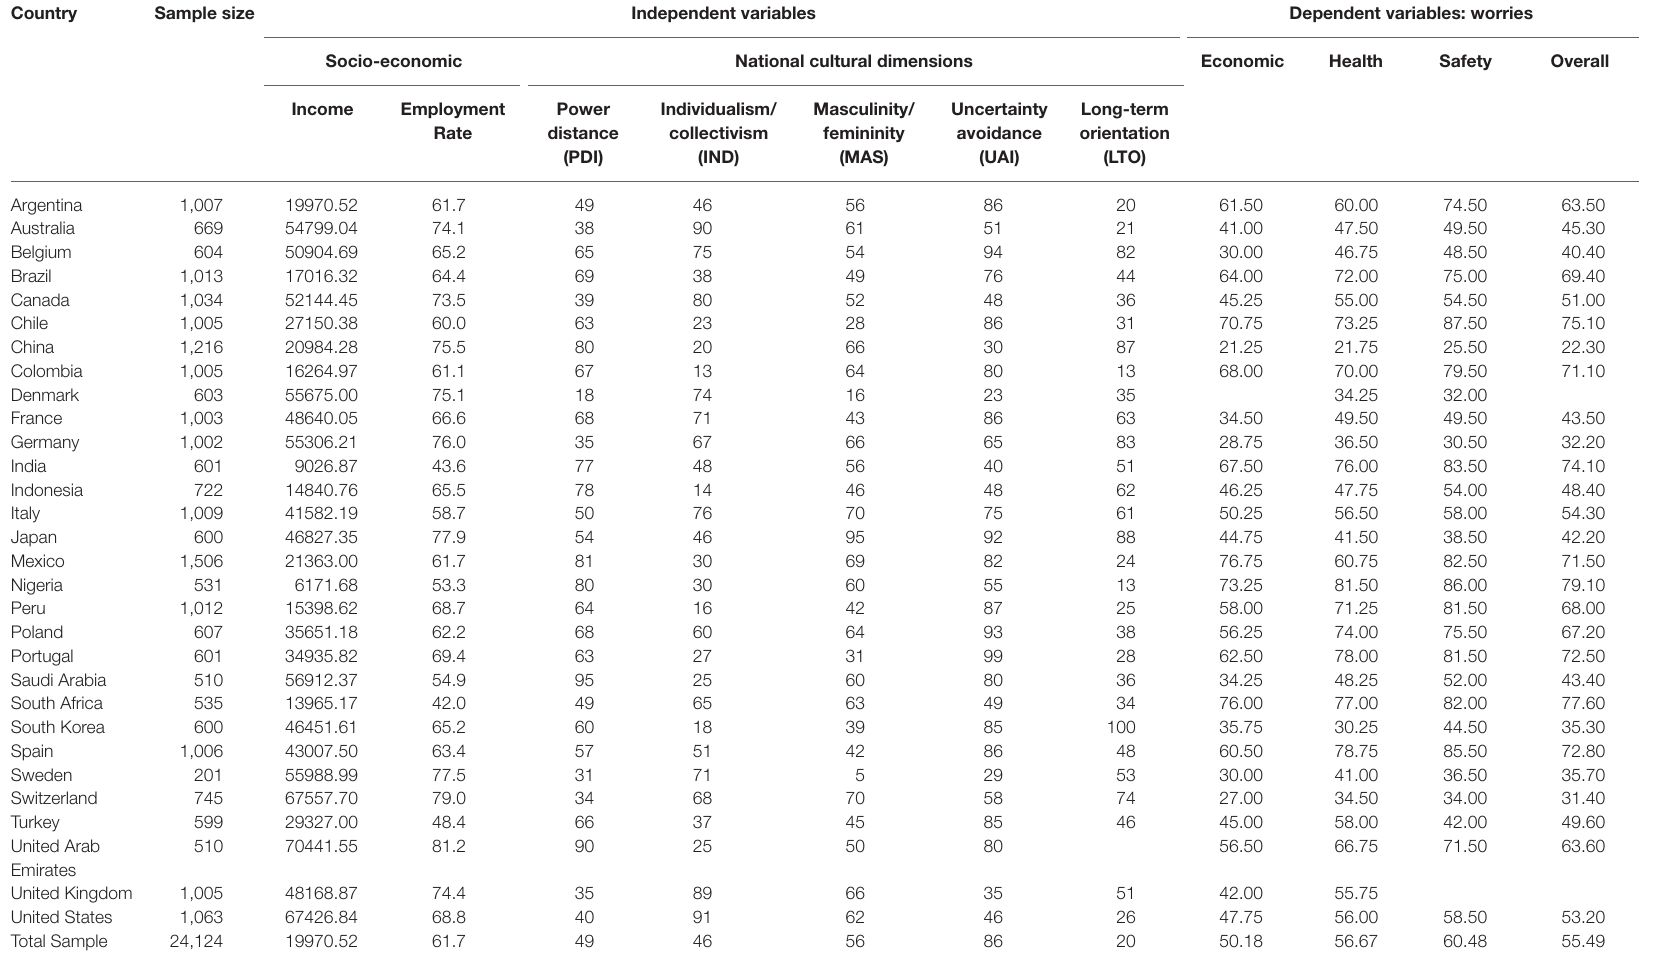
TABLE 1 | Countries considered in the study (in alphabetical order) and values for the dependent and independent variables. Country Sample